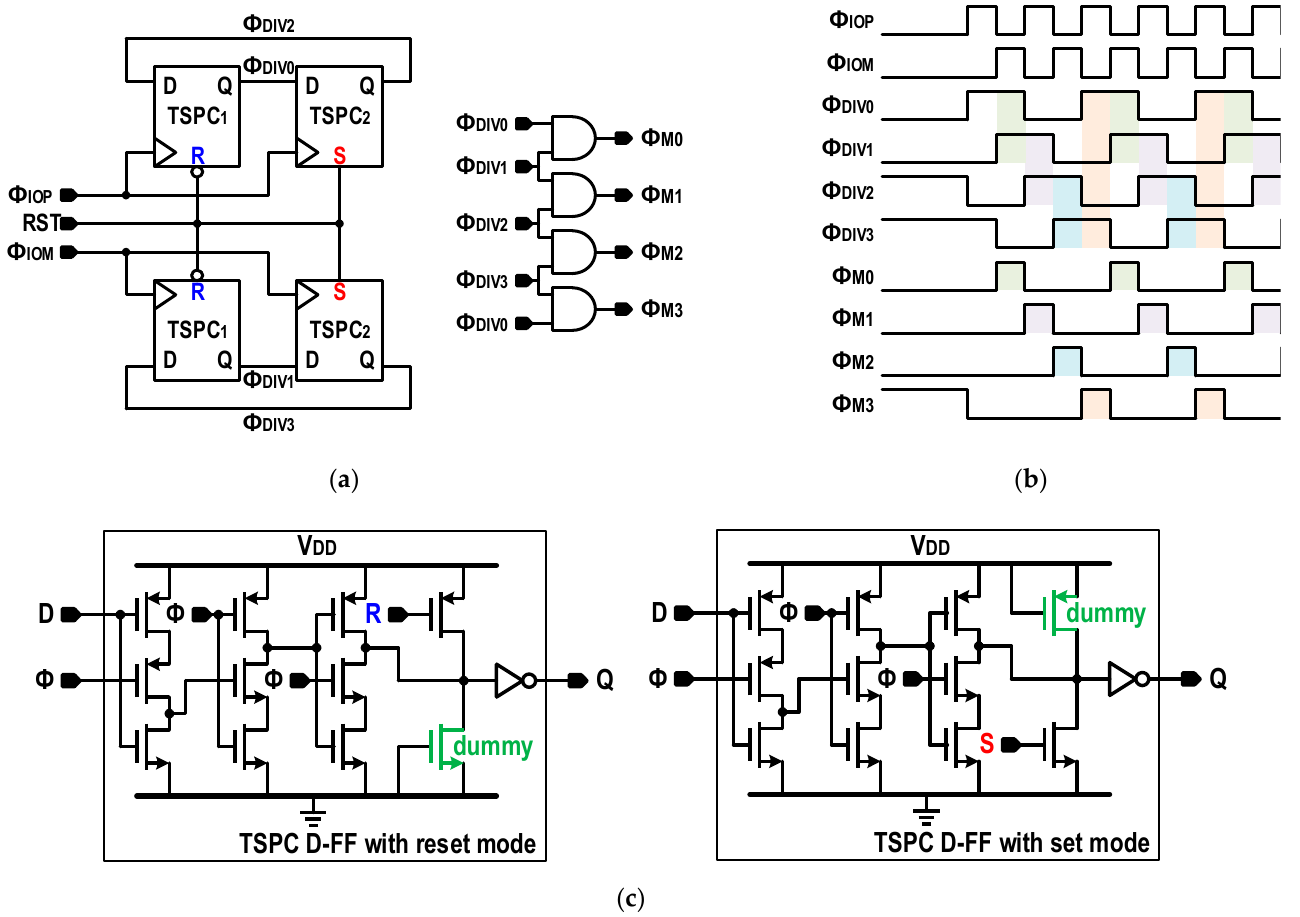
Figure 9. Main clock generator. ( a ) Multi-phase generation logic. ( b ) Timing diagram. ( c ) Circuits for the TSPC DFF with set and reset modes.